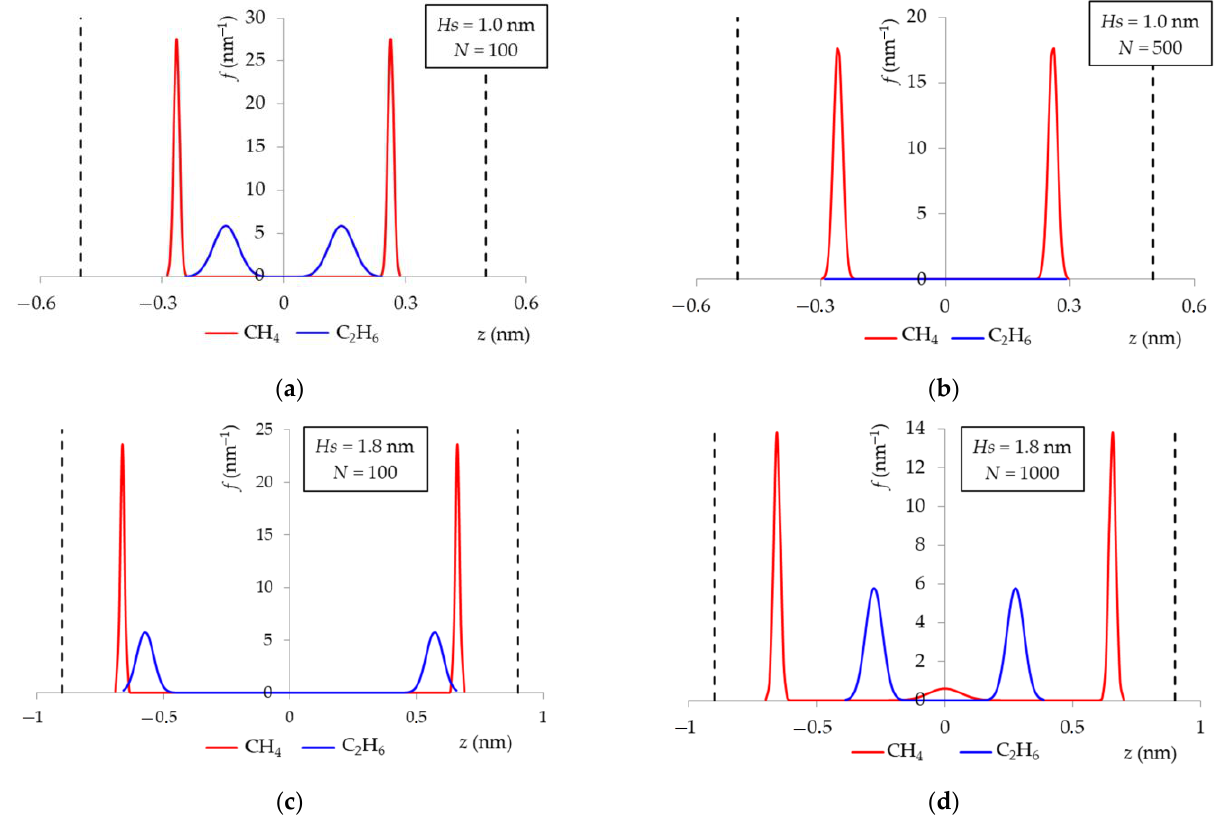
Figure 10. Probability density of the mass center location of a methane and ethane molecule in a model pore of a carbon adsorbent with a width of H S = 1.0 nm ( a , b ) and 1.8 nm ( c , d ) for different numbers of molecules N in the simulation cell, corresponding to the region of averages ( a , c ) and maximum ( b , d ) fillings of micropores. The number of molecules of the mixture N (the ratio of the molecules number of methane and ethane is 95:5) in the modeling system, pcs: 100 ( a ); 500 ( b ); 100 ( c ); 1000 ( d ). The temperature is 293 K. The ordinate axis intersects the abscissa axis at point z = 0, corresponding to the symmetry plane of the pore. The dotted line is the boundary of the model micropore.